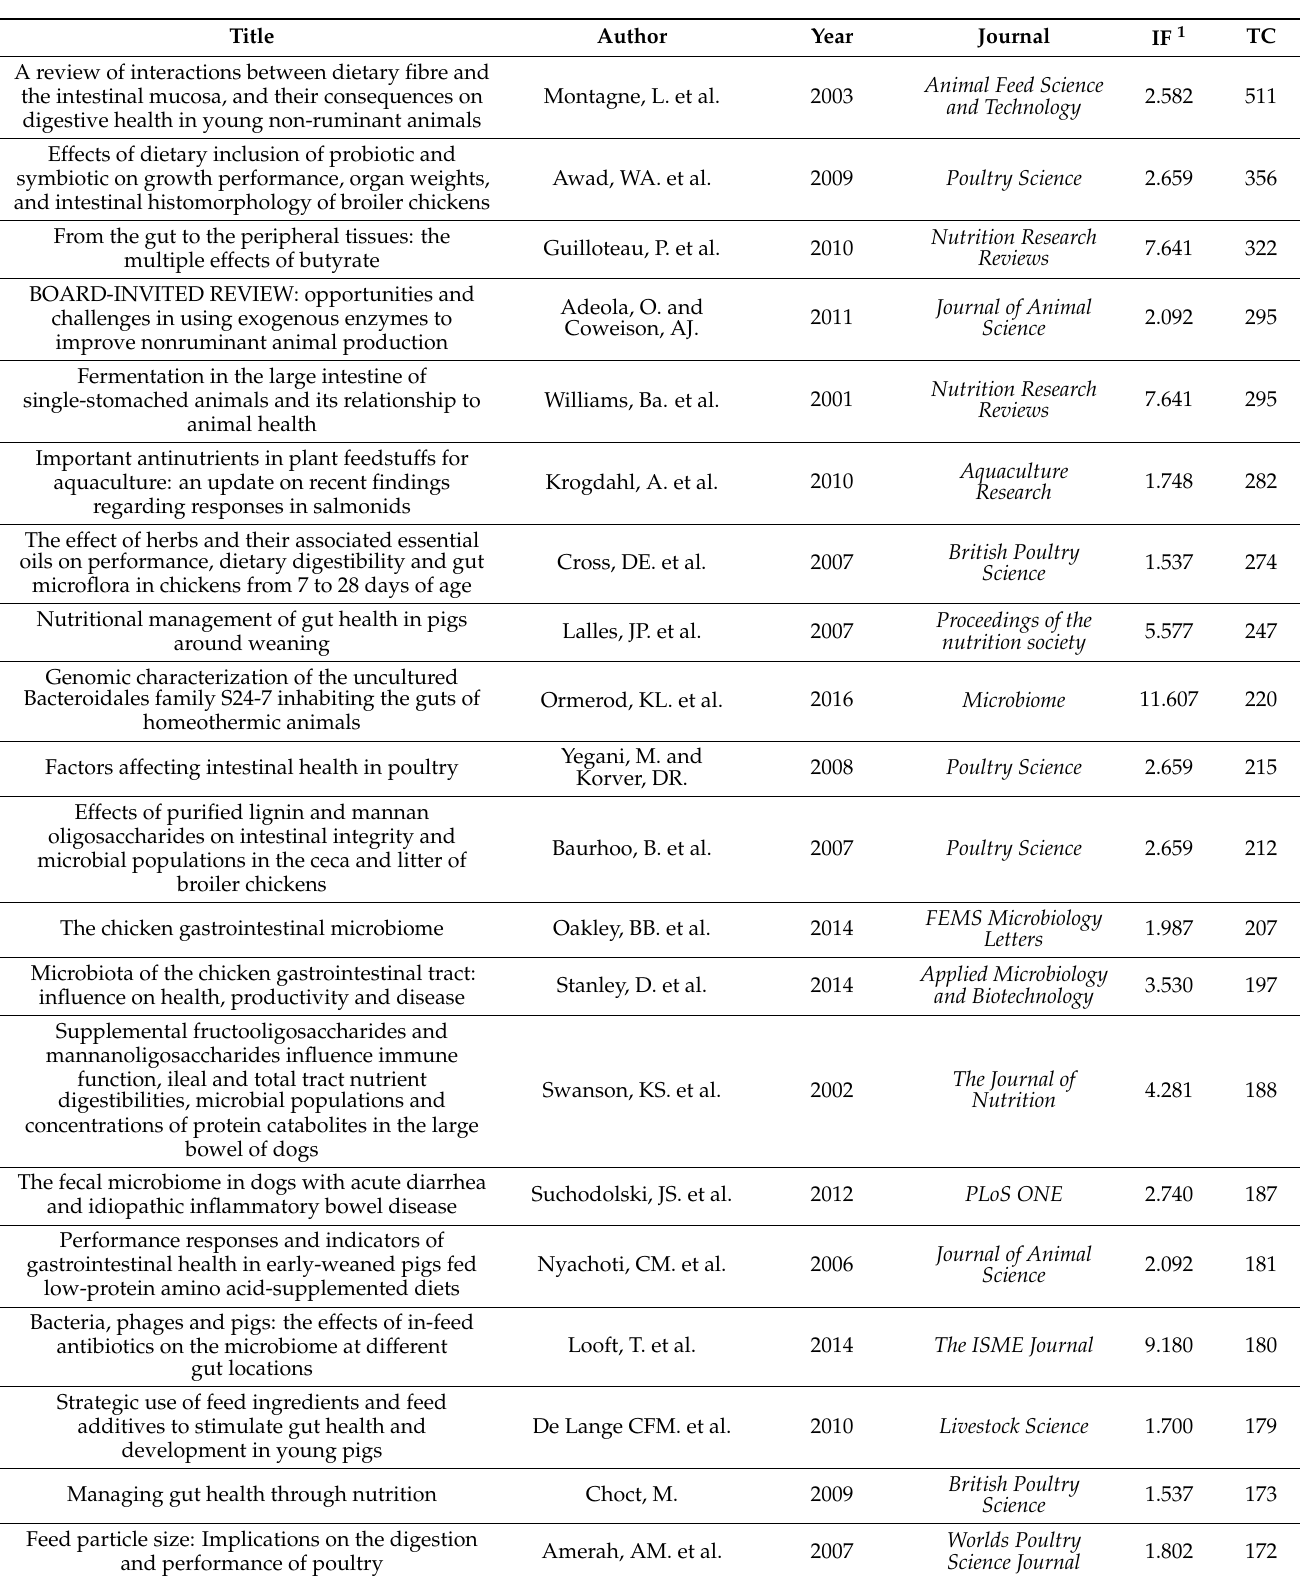
Table 5. Top 20 most cited articles on veterinary gut